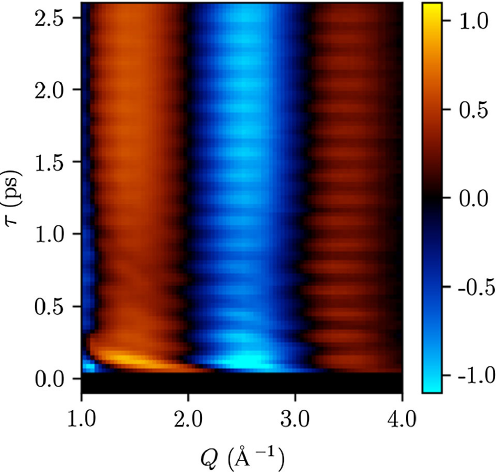
FIG. 5. S 0 ð Q; τ Þ : Scattering data projected on to P 0 ð cos θ Þ minus unpumped scattering.